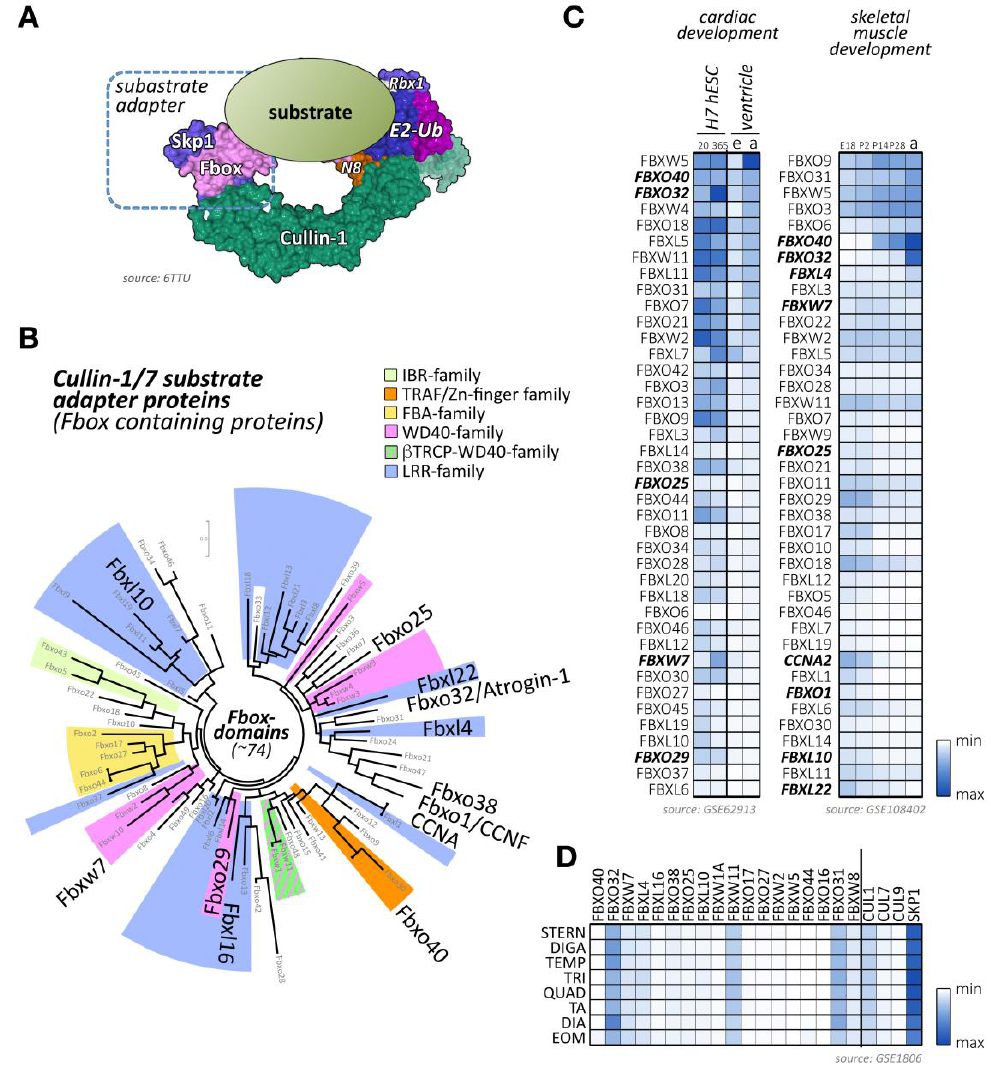
Figure 3. Cullin-1/7 substrate adapters of the F-box family. ( A ) Schematic view of a neddylated cullin-1 E3-ligase bound to Rbx1 and an Skp1-associated F-box protein, as well as a ubiquitin-loaded E2-enzyme. The substrate with a target lysine for (poly-) ubiquitylation is positioned by the fully assembled cullin-1 E3-ligase in close proximity to the enzymatically active Rbx1 and E2 proteins. Surface representation is from structure 6TTU [10]. ( B ) Maximum likelihood molecular phylogenetic tree analysis of human F-box domain-containing proteins. Adapter protein families for the cullin-1/7 E3-ligase, identified by their other domains are highlighted, as are F-box proteins with known functions for cross-striated muscles. ( C ) Heatmap analysis of F-box protein mRNA expression levels during cardiac development (differentiation of H7 human embryonic stem cells into cardiomyocytes at day 20 and day 365; embryonic (e) or adult (a) mouse ventricular tissue; left panel) and skeletal muscle development (at embryonic day E18, and postnatal days 2, 14, 28, and adult stages; right panel). Shown are the top 40 F-box-proteins with the highest mRNA levels in skeletal and cardiac muscles. Adapter proteins with known functions for heart or skeletal muscle are highlighted. Data were adapted from GSE62913 and GSE108402 [91,92]. ( D ) Muscle-type specific mRNA expression analysis of top 18 F-box-containing adapter proteins with known roles in cross-striated muscles, as well as cullin-1, cullin-7, cullin-9, and Skp1. Analyzed adult muscles were sternomastoid (Stern), digastric (Diga), temporalis (Temp), triceps (Tri), quadriceps femoris (vastus lateralis; Quad), tibialis anterior (TA), diaphragm (Dia), and extraocular muscle (Eom). Data were adapted from GSE1806 [93].